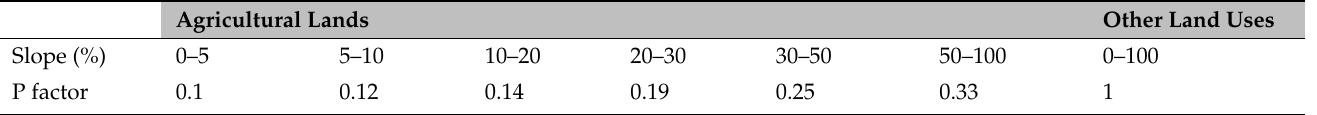
Table 1. Relationship between slope (%) and the P factor value for different land uses following the “Wischmeier”